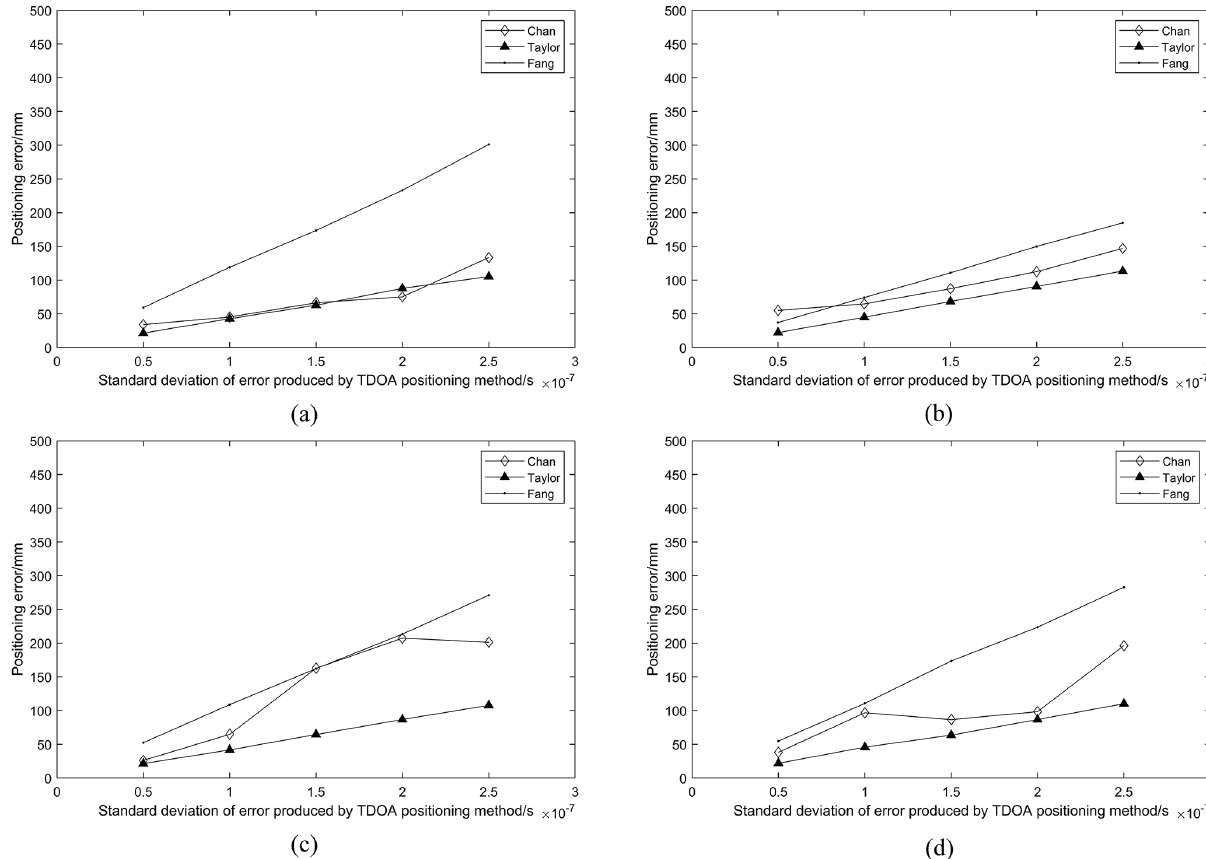
Figure 8. Comparison of the positioning performance of the Chan, Taylor, and Fang algorithms.